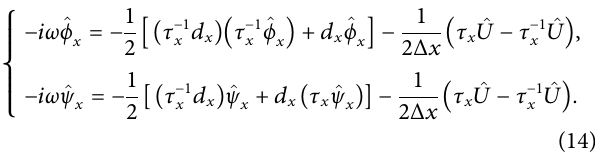
Frontiers in Earth Science |